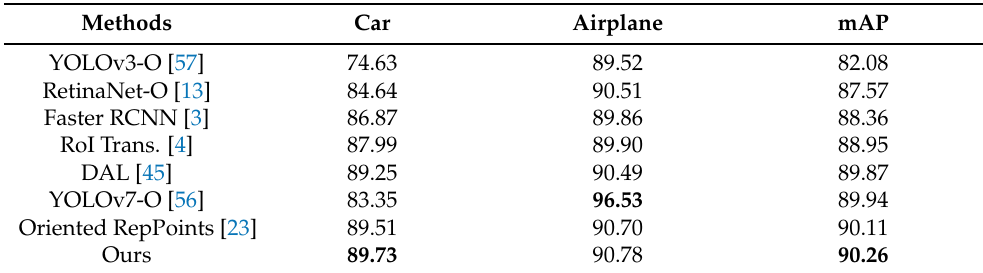
Table 3. Results on UCAS-AOD. The best result is bolded in each column.